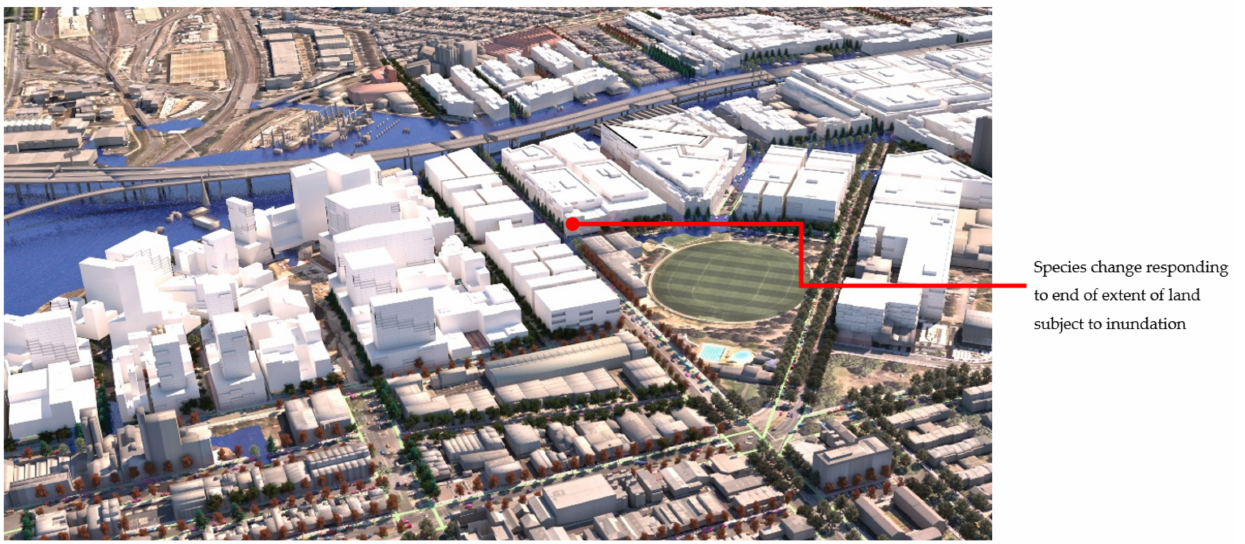
Figure 12. Rendering, aerial view under flood condition for scenario (1), ‘Land subject to inundation’. This results in changes of species that may cross roads or alter with no physically apparent infrastruc- ture. Image by authors using multi-criteria street tree design decision support modelling approach in Autodesk™ 3ds